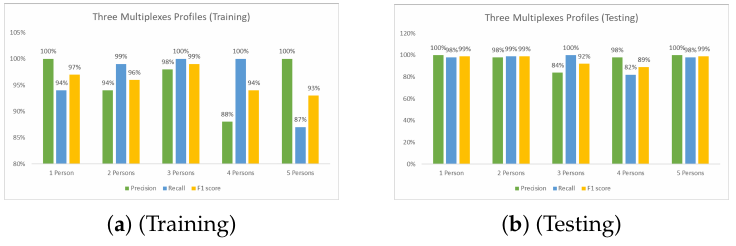
Figure 28. TAWSEEM: precision, recall, and F1-score (three multiplexes